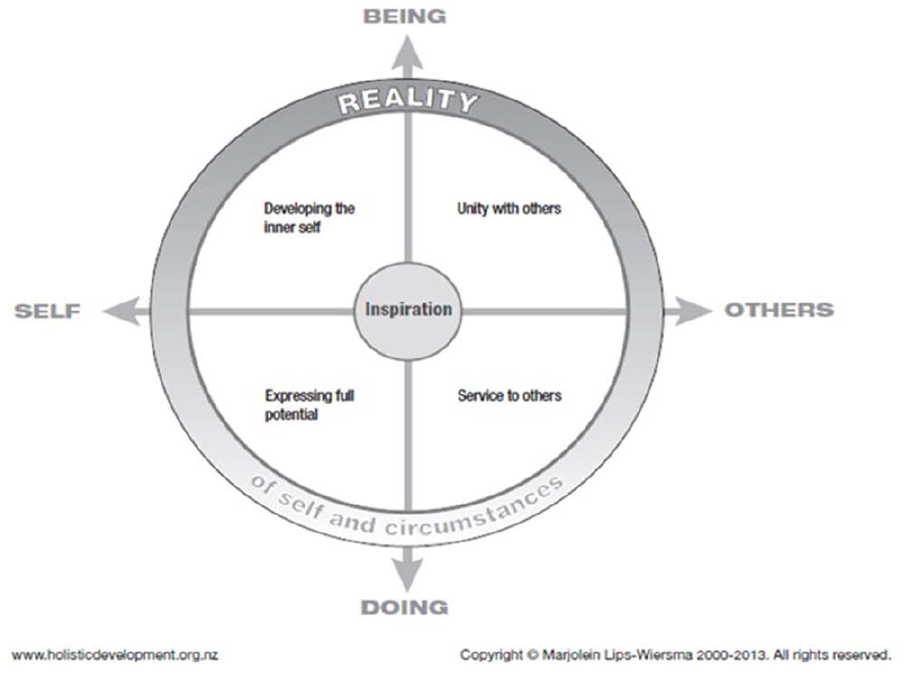
Figure 2. The Map of Meaning Source: Lips- Wiersma & Morris (2011)